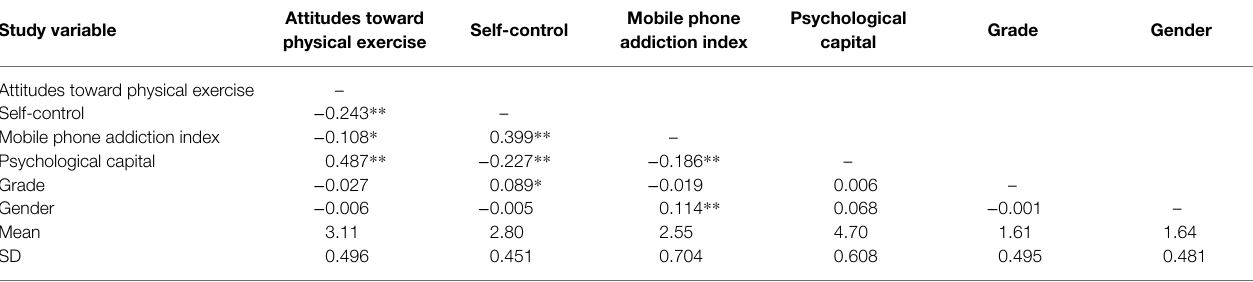
TABLE 1 | Mean, standard deviation (SD), and Pearson product–moment correlation matrix of study variables based on 519 questionnaires. Study